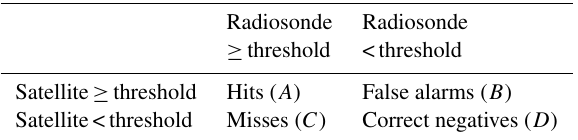
Table 2. Contingency table for the comparison of INSAT-3D esti- mated CAPE with radiosonde measured CAPE. The CAPE thresh- old is considered as 0Jkg − 1